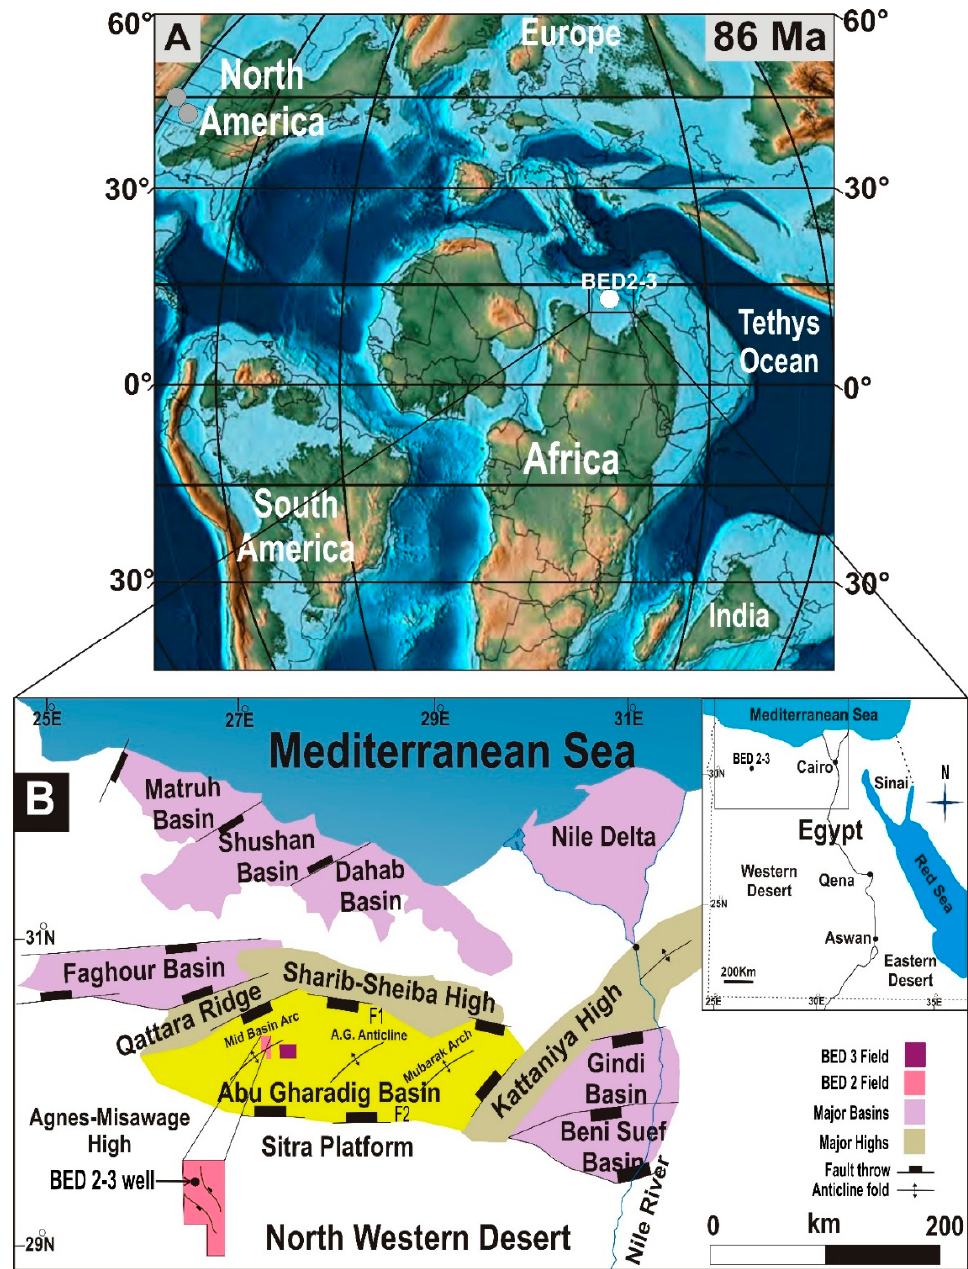
Figure 2. ( A ) Paleogeographic map during the Coniacian-Santonian (including topography and bathymetry, after [31]. ( B ) Location map with major structural features of the north Western Desert, including the BED2-3 well in the Abu Gharadig Basin.